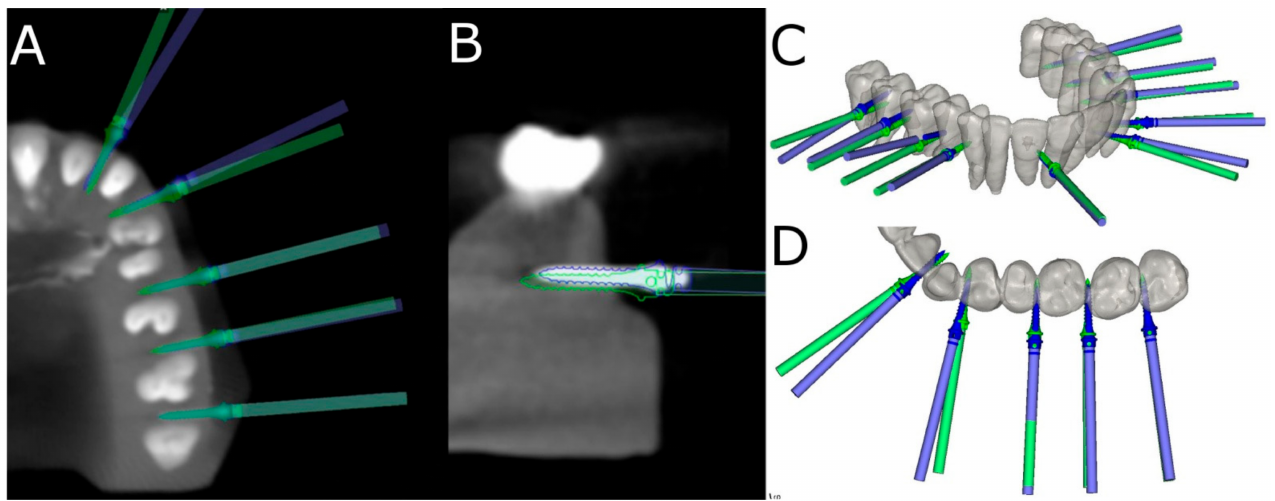
Figure 3. ( A – D ) Deviations measurement procedure between planned (green cylinder) and placed (blue cylinder) orthodon- tic micro-screws in the computer-aided static navigation technique study group.